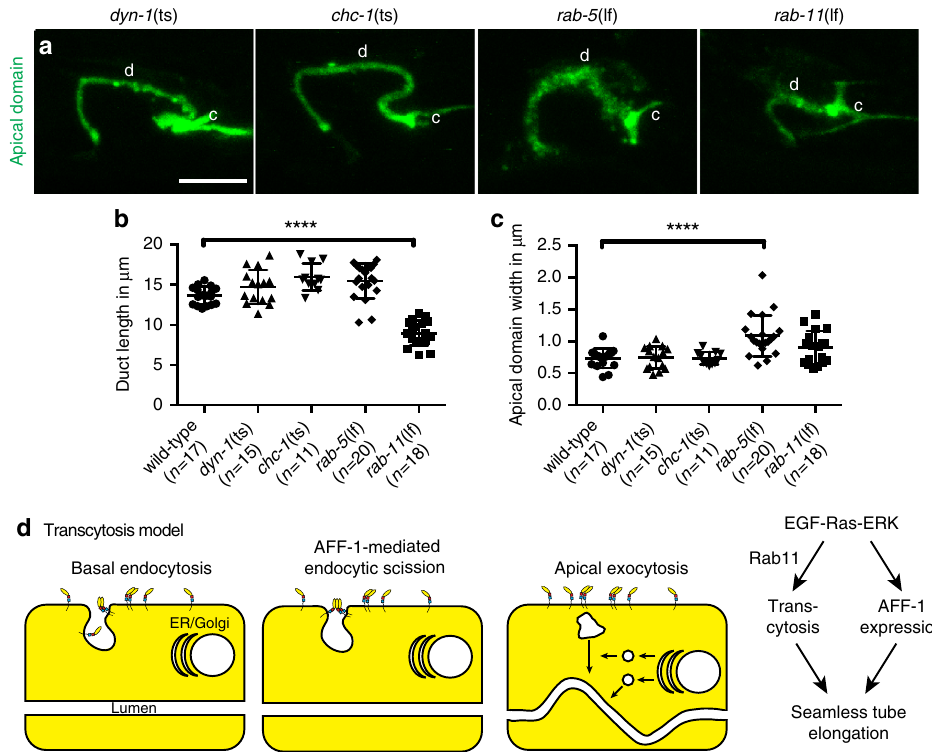
Fig. 7 Duct lumen elongation requires RAB-11. a Confocal Z-projections of L1 larvae-expressing apical domain marker RDY-2::GFP. d, duct; c, canal. dyn-1 ( ky51ts ) and chc-1 ( b1025ts ) mutants resemble wild-type (see Fig. 2b). In rab-5 ( ok2605 ) mutants, the apical signal is disorganized and widened. In rab-11 ( tm2063 ) mutants, the apical domain is shorter and compared to wild-type. b , c Measurements of duct length and apical domain width, respectively. **** = p -value <